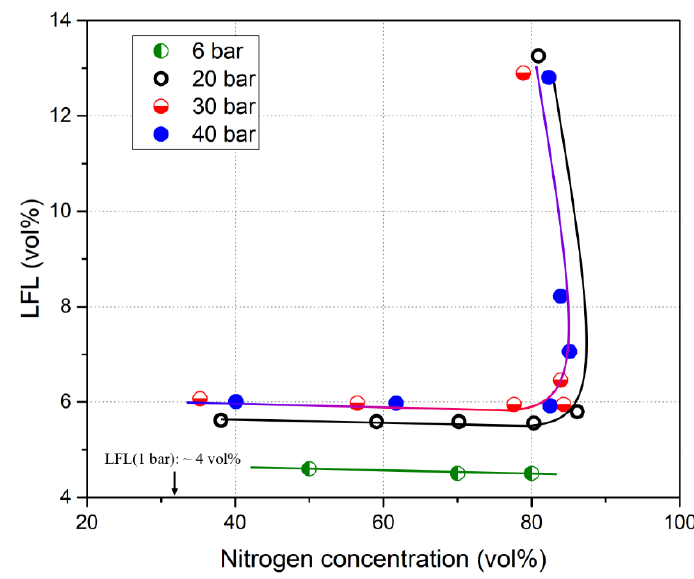
Figure 6. Flammability limits in H 2 -O 2 -N 2 mixtures at temperature 20 °C. Reproduced from [37], The Combustion Institute: 1995.